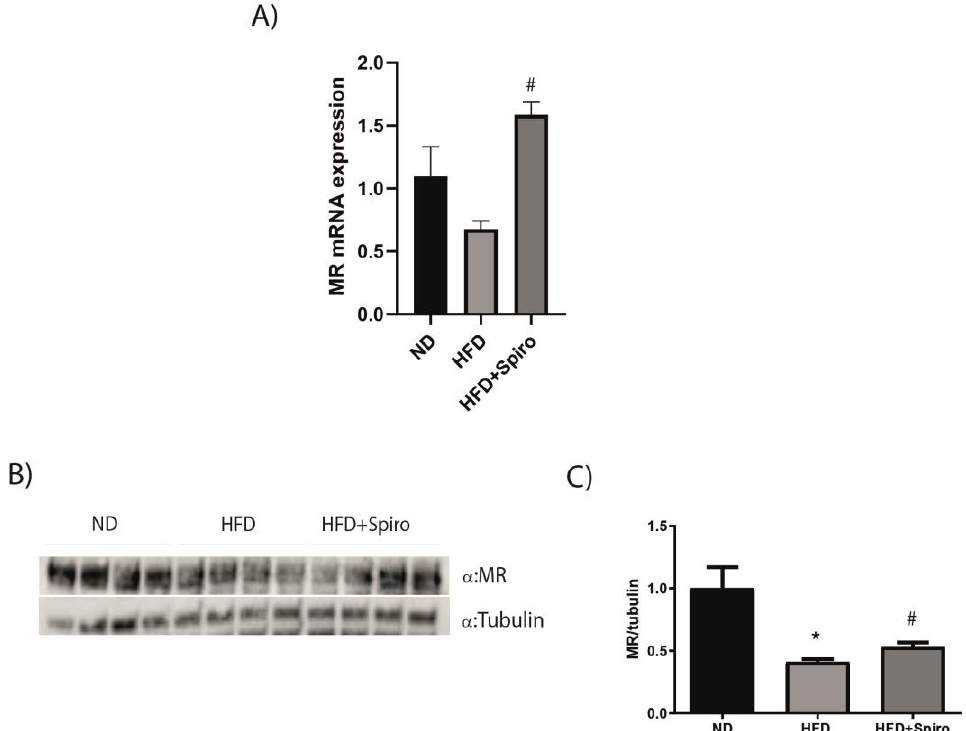
Figure 2. MR expression is downregulated by HFD compared to ND mice and Spiro treatment partially reverts this effect in HFD + Spiro mice. ( A ), qRT-PCR analysis of MR gene expression in GA of ND, HFD, and HFD + Spiro groups (n = 10). ( B ), representative immunoblots of MR expression analysis in GA (n = 10), and ( C ) distribution graphs of the densitometric scanning analyses performed by ImageQuant TL software by using α-tubulin as a loading control. * p < 0.05 vs. ND; # p < 0.05 vs. HFD. Values are expressed as means ± SEM.